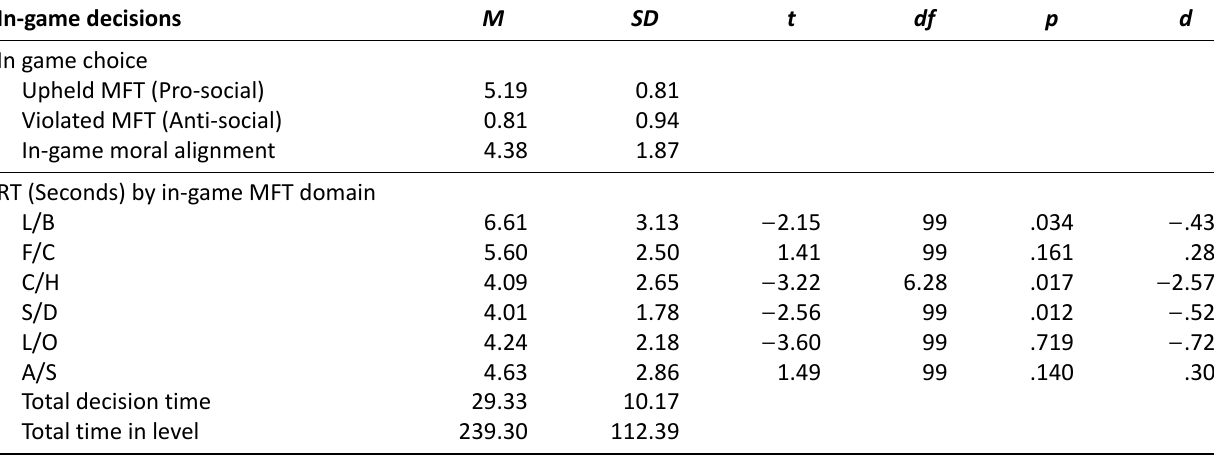
Table 1. Summary of descriptive statistics of the in-game moral decisions. In-game